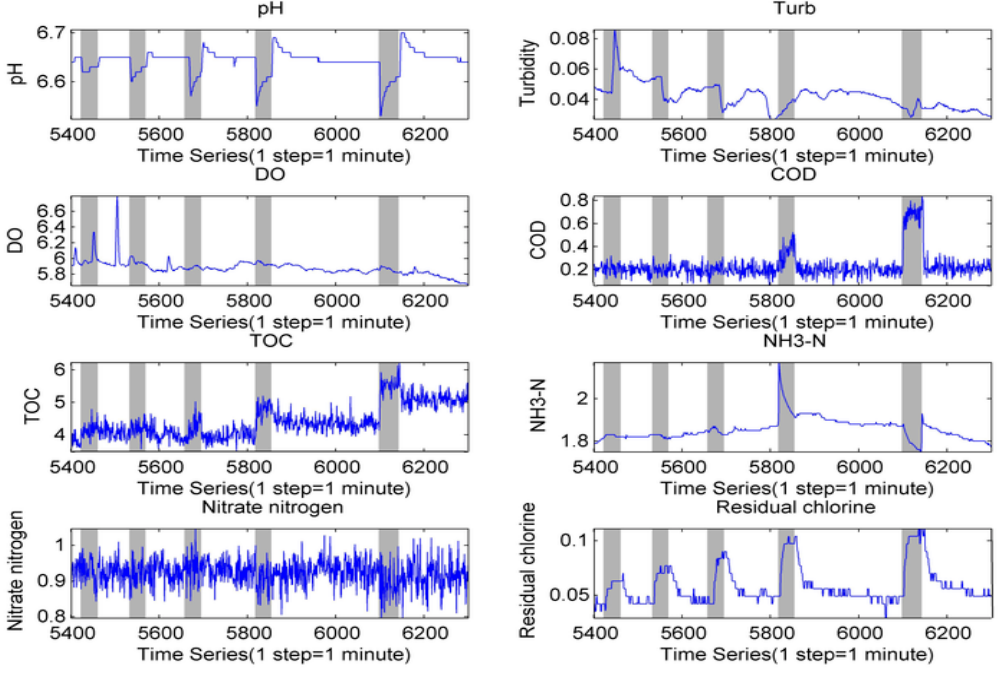
Figure A3. Sensors’ responses for copper sulfate.